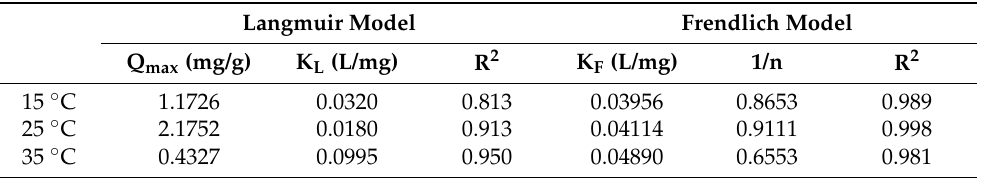
Table 3. Fitted parameters of adsorption isotherms. Langmuir